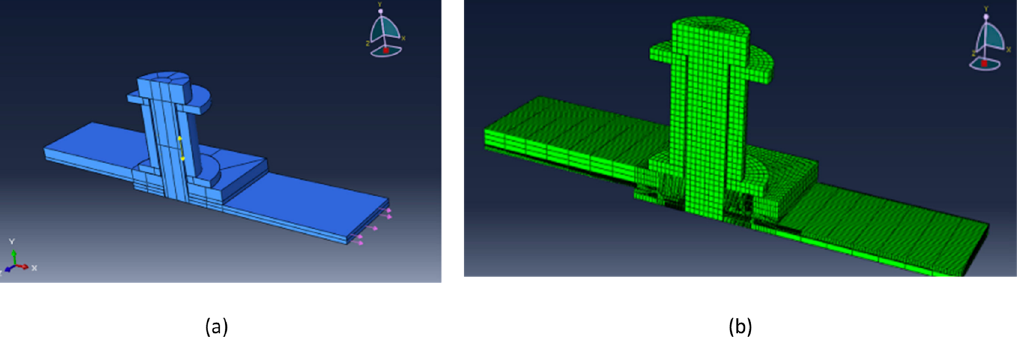
Figure 19. FEA model showing ( a ) the boundary conditions of DLBJ, ( b ) mesh generation in the geometry [123].